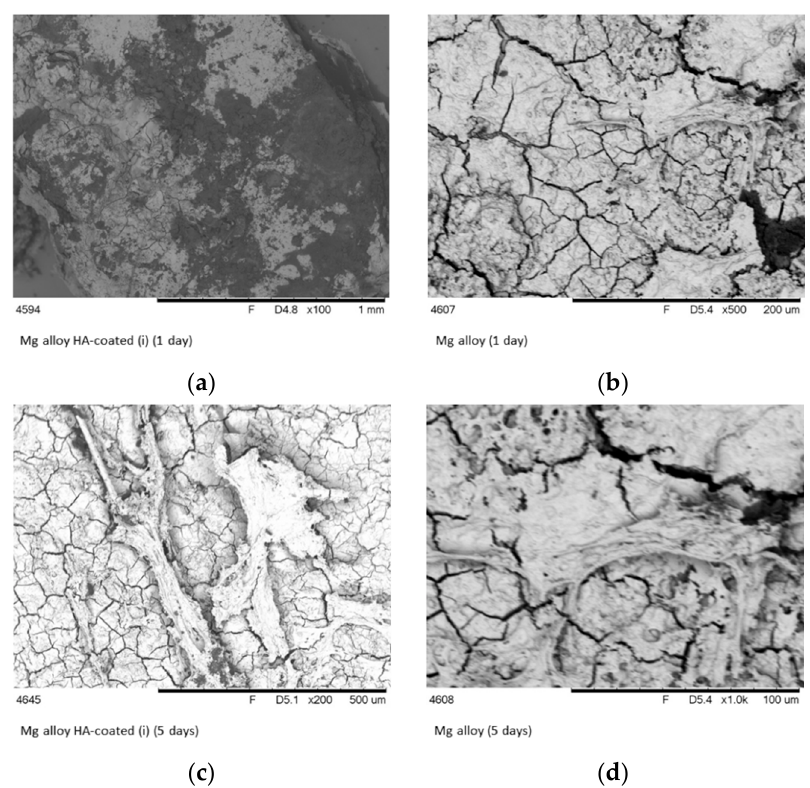
Figure 6. SEM images of the surface of HA–Mg coatings ( a , c ) and Mg-alloys ( b , d ) after one and 5 days of implantation in bone tissue.